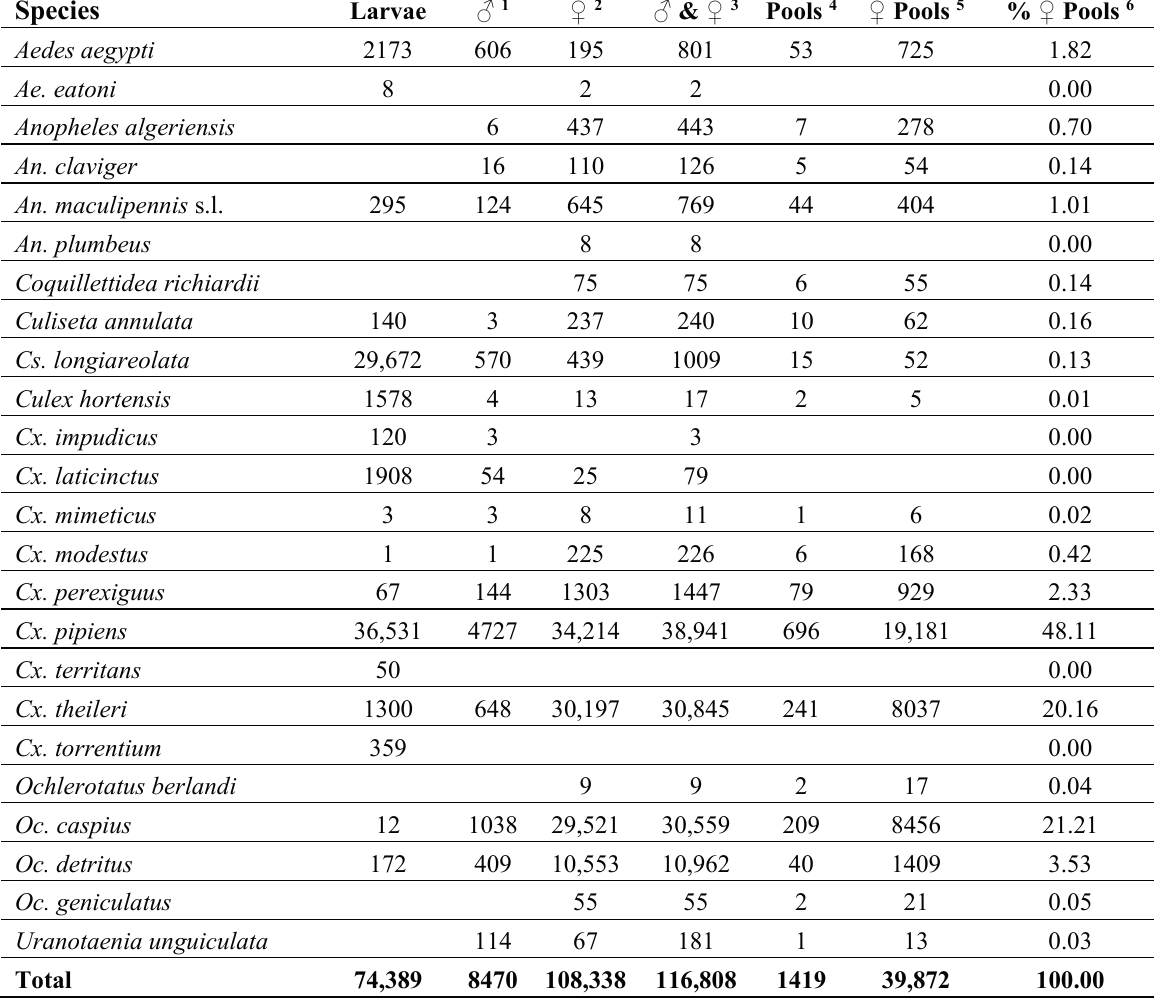
Table 2. Mosquito species collected in Portugal in the frame of